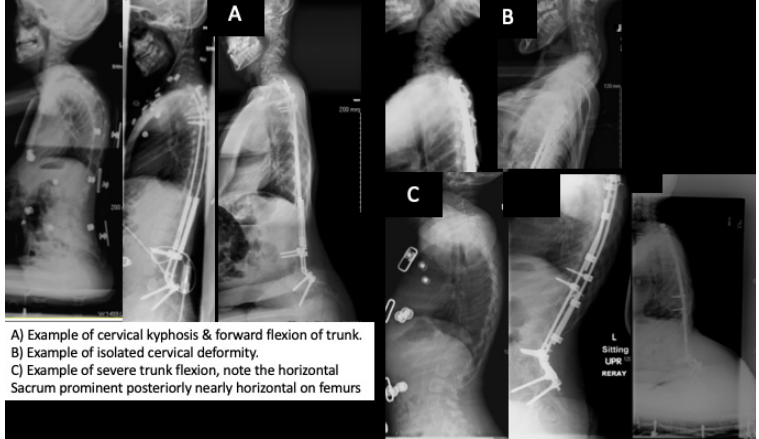
Figure 4. Examples of the cervical ( A , B ) and trunk deformities ( A , C ) developing over time.